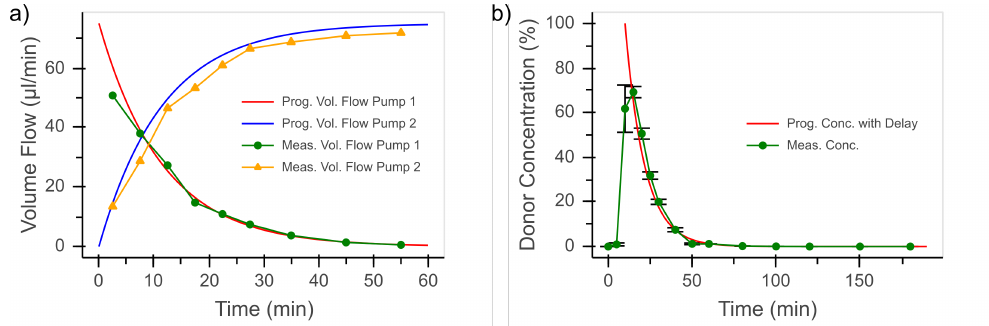
Figure 6. ( a ) Comparison of the programmed and experimentally determined volume flows of Pumps 1 and 2. ( b ) The programmed donor concentration profile according to Equation (1) with a time delay (10 min) compared to the measured donor concentration profile compared to the desired concentration profile (n = 2).